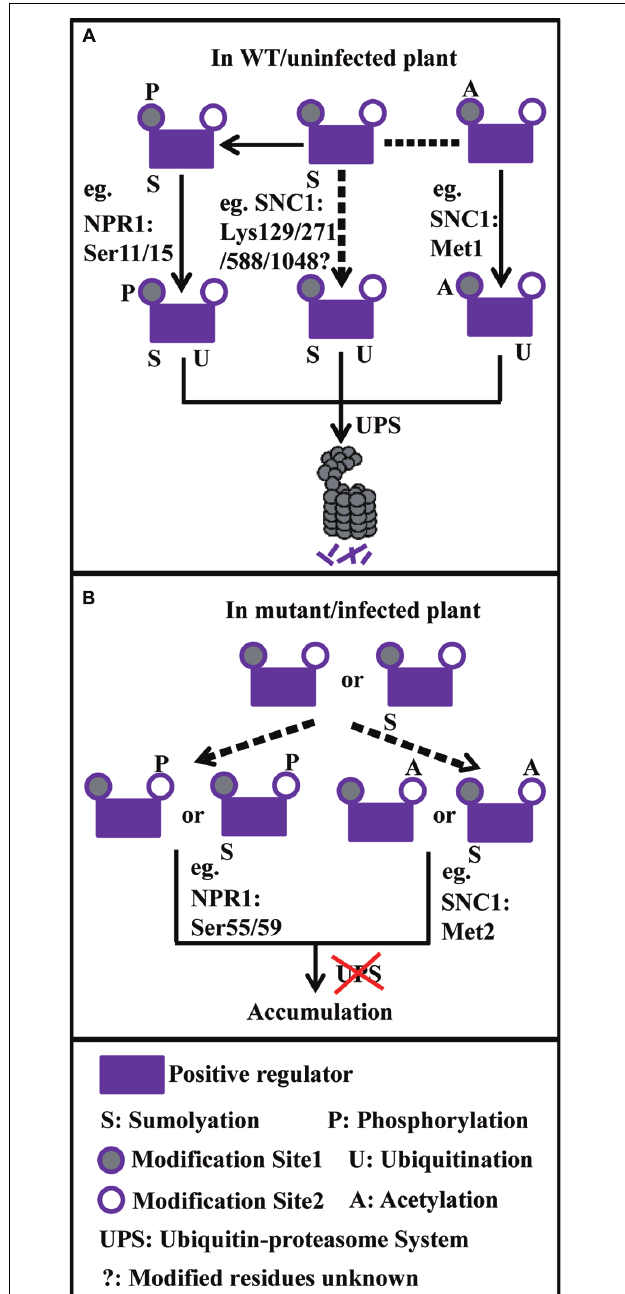
FIGURE 1 | Model on how ubiquitination reacts with sumoylation, phosphorylation, and acetylation to fine-tune the turnover of plant immune components. (A) Under normal conditions, sumoylated positive regulators further go through phosphorylation or acetylation on the site1 (e.g., NPR1: Ser11/15 and SNC1: Met1, respectively), which serves as degron, leading to protein degradation through the UPS. Or protein sumoylation alone (e.g., SNC1: Lys129/271/588/1048) may promote its degradation through the UPS. (B) Under abnormal conditions, positive regulators or sumoylated positive regulators go through phosphorylation or acetylation on the site2 (e.g., NPR1: Ser55/59 and SNC1: Met2, respectively), which prevents protein degradation through the UPS, leading to protein accumulation. In the model, dash arrows stand for uncertain